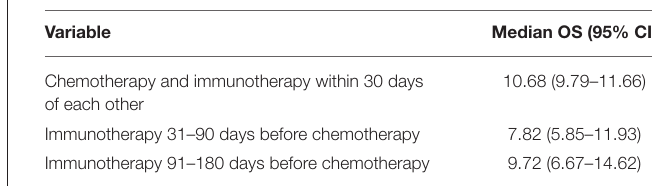
TABLE 2 | Median OS of chemotherapy and immunotherapy sequence